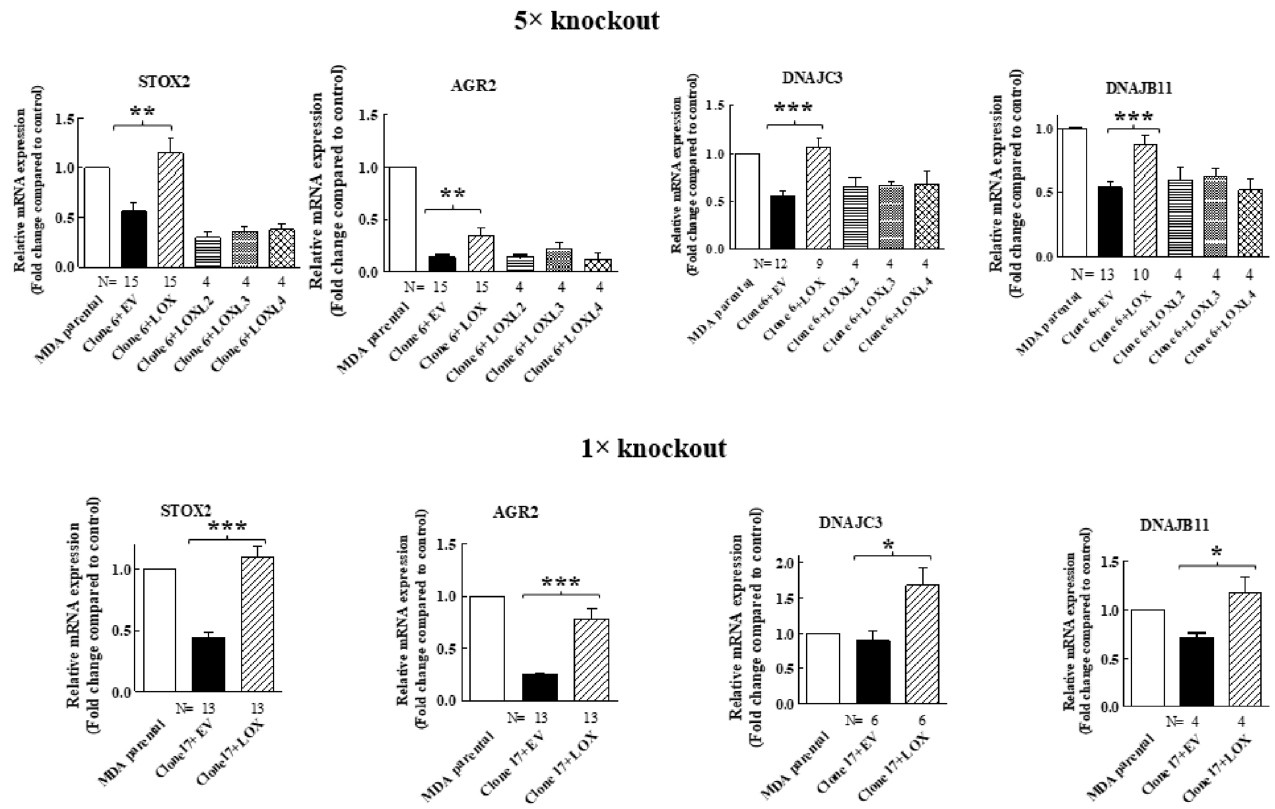
Figure 3. The expression of STOX2, AGR2, DNAJB11 and DNAJC3 is rescued by LOX re-expression but not by re-expression of other lysyl-oxidases, with qRT-PCR analysis of the effects of the re-expressed lysyl-oxidases in 5× clone 6 and 1× clone 17 knock-out cells on the expression of the indicated genes. No epitope tags were added to the cDNAs encoding the different lysyl-oxidases. Results were normalized with the expression level in MB-MDA-231 parental cells in each of the experiments. Data represent the mean ± SEM of N independent experiments. Statistical significance was evaluated using unpaired student’s t test with Welch’s correction. * p < 0.05, ** p < 0.01, *** p < 0.001.